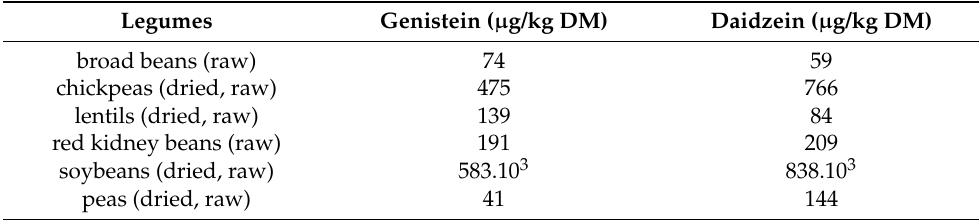
Table 5. Concentration ( µ g/kg DM) of genistein and daidzein in different legumes